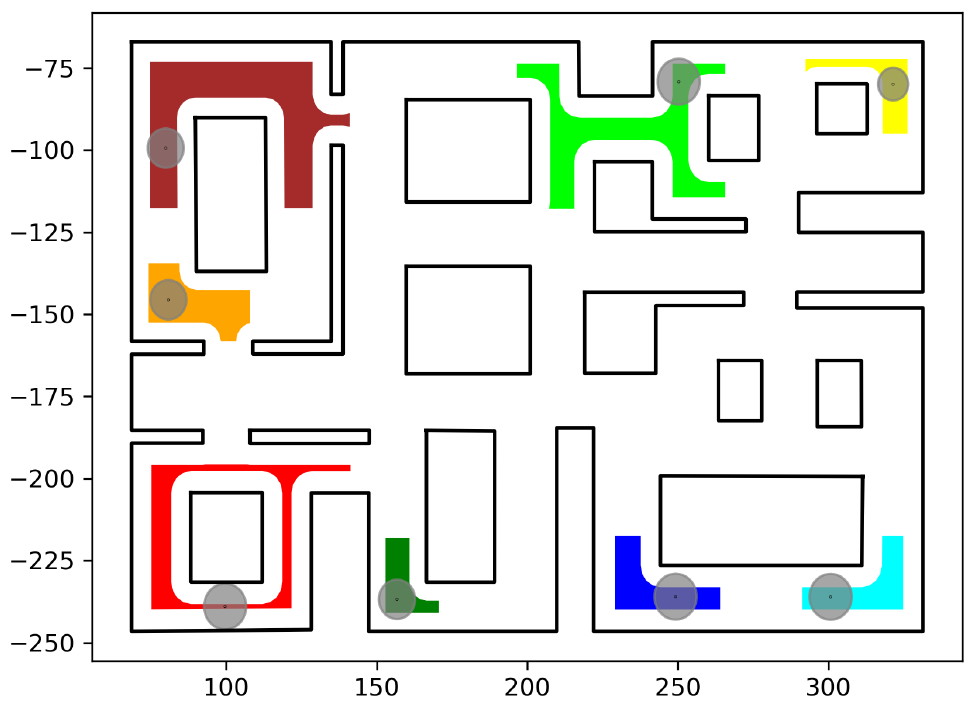
Figure 11. The desired robot positions p des, i , i ∈ I 8 and calculated goal compound cell (cid:98) C goal . Robot #1 (red); Robot #2 (green); Robot #3 (dark red); Robot #4 (orange); Robot #5 (yellow); Robot #6 (dark green); Robot #7 (blue); Robot #8 (cyan). The axes units are in (dm).